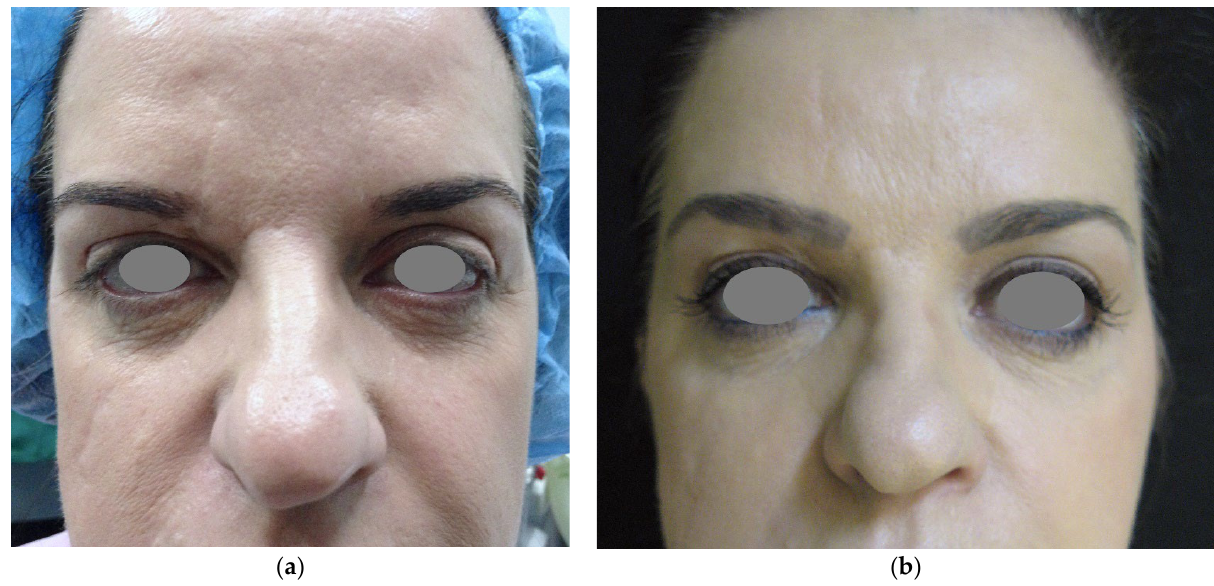
Figure 2. 53-year-old patient with a traumatic scar on the glabella. ( a ) Before and ( b ) after fractional CO 2 laser and superficial injection of HAF.